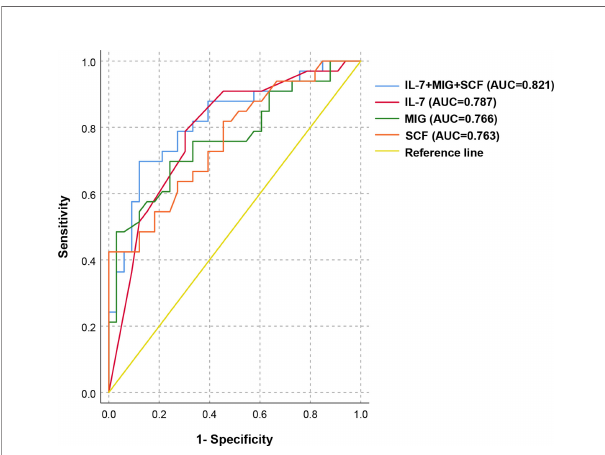
FIGURE 3 | ROC analysis of the combined prediction model for the prediction of PIH in ART pregnancy. ROC curves show the results of ROC analysis for differentiation between PIH and NC in ART pregnancy. ROC curve analysis revealed that IL-7, MIG, and SCF appeared to be potential biomarkers for the separation between PIH and NC in the fi rst trimester of pregnancy (AUC = 0.821, 95% CI: 0.718-0.924, P < 0.001), with a sensitivity of 81.8% and a speci fi city of